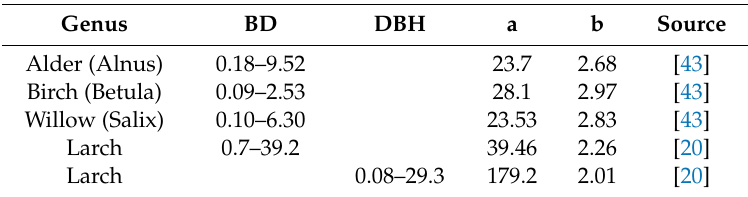
Figure 1. A map of the study area in northeastern Siberia, Russia. Panel ( A ) shows the location of the study area in Northeastern Siberia, Russia outlined by the blue box, which highlights the area of the inset map. The inset map shows the location of the transects that are labeled with a background of a composite Landsat image. Panel ( B ) shows the NDVI image calculated from the multispectral UAV data for the CN transect 1. Panel ( C ) shows the visible spectrum (RGB) UAV data for the CN transect 1. Table 1. Details for the allometric equations used to calculate biomass for field-based measures of trees [20] and shrubs [43]. The equation was biomass = axˆb (x = BD or DBH), where values for a and b are listed in the table and correspond to the basal diameter (BD) or diameter at breast height (DBH) of the field-based measures